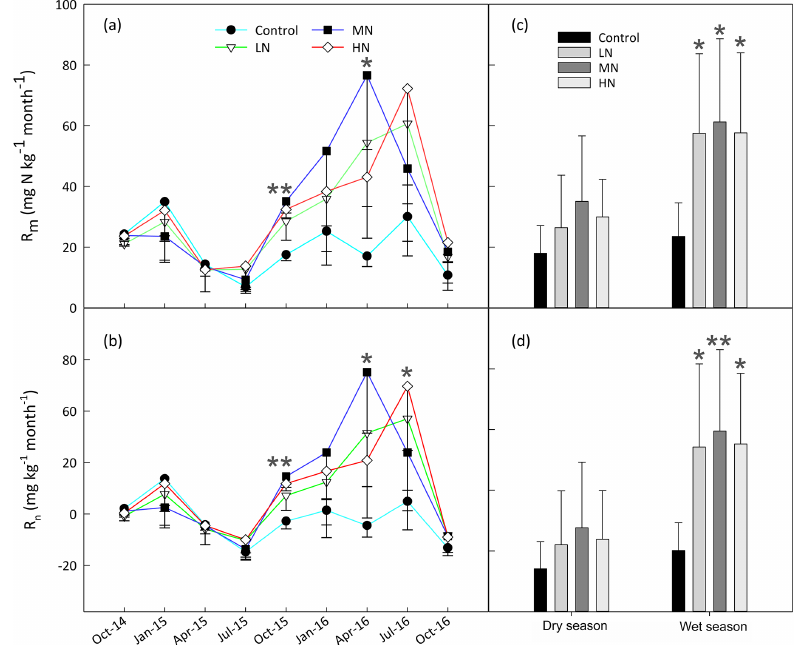
Figure 2. The variation in the in situ mineralization rate ( R m ) (a) and nitrification rate ( R n ) (b) in the soils at different samplings. The R m (c) and R n (d) in the dry and wet seasons. Bars represent standard errors of the mean ( n = 3). Significance levels are indicated by ∗ P < 0 . 05, ∗∗ P < 0 .